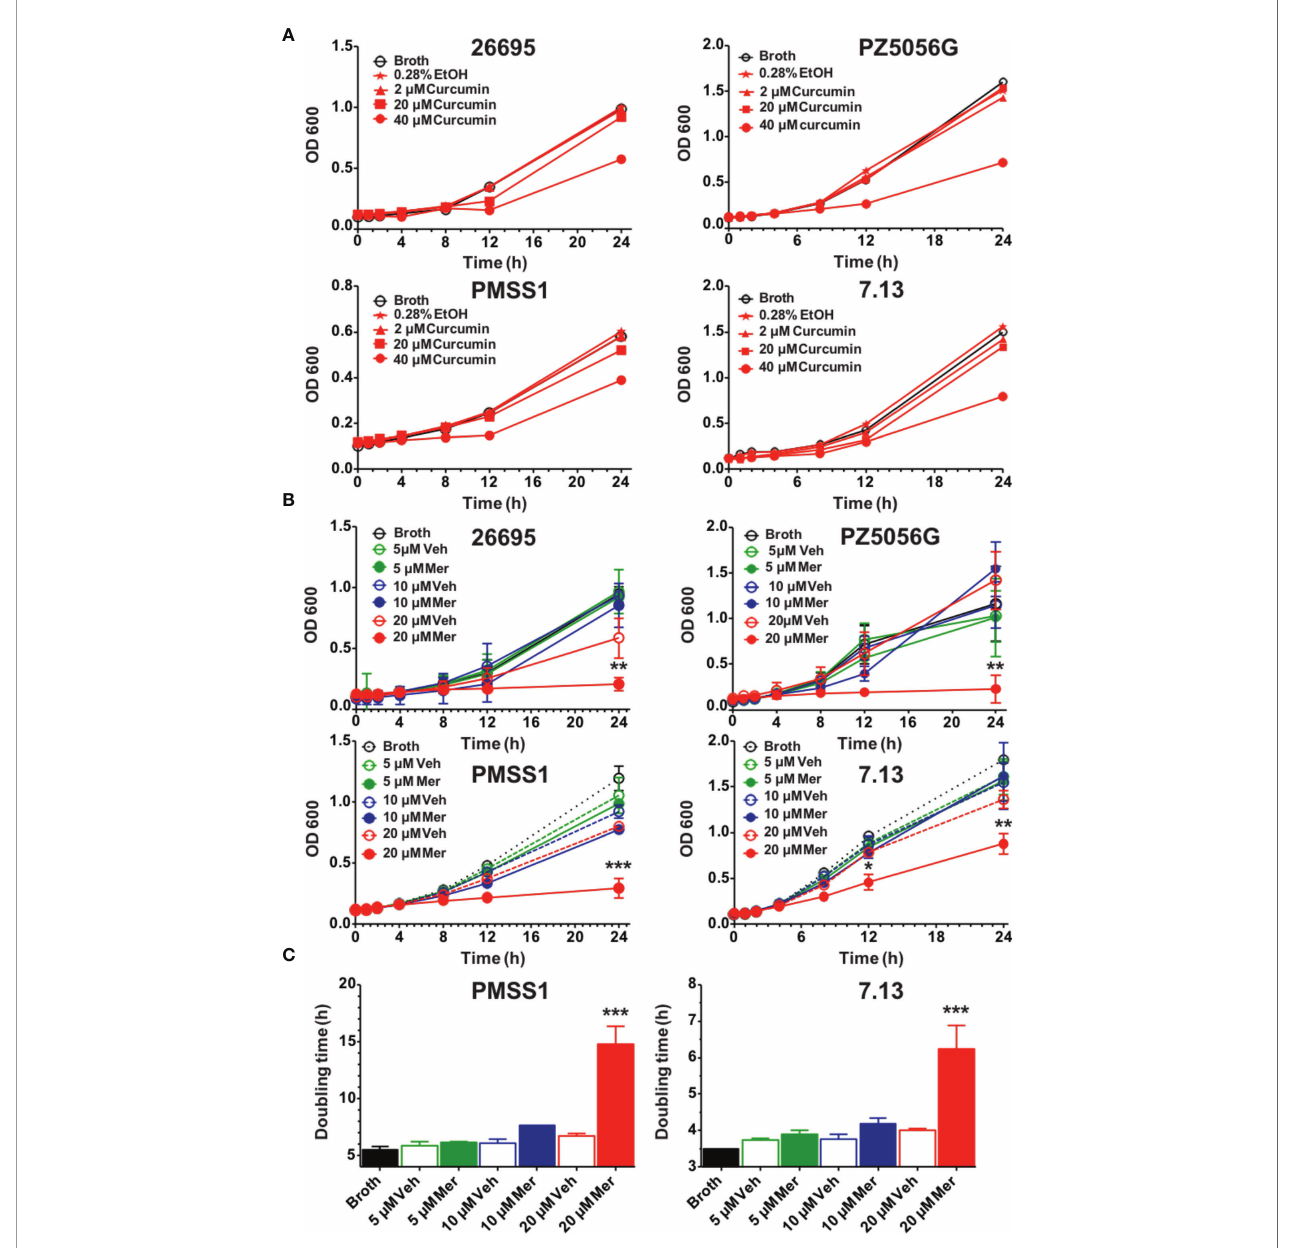
FIGURE 1 | Effects of curcumin and phospholipid encapsulated curcumin (Meriva) on growth of four prototype strains of H. pylori . (A) Four strains of H. pylori (26695, PZ5056G, PMSS1, and 7.13) (0.1 OD) were grown in the presence of vehicle (ethanol) or increasing concentrations of curcumin, and growth was determined at the indicated time points. (B) Growth curve of H. pylori strains 26695, PZ5056G, PMSS1, and 7.13 cultured in the presence of a phospholipid formulation of curcumin (Meriva, Mer) or vehicle control (Veh, ethanol). (C) Generation time of H. pylori PMSS1 and 7.13 as determined from the growth curves (** P value < 0.005 *** P value <